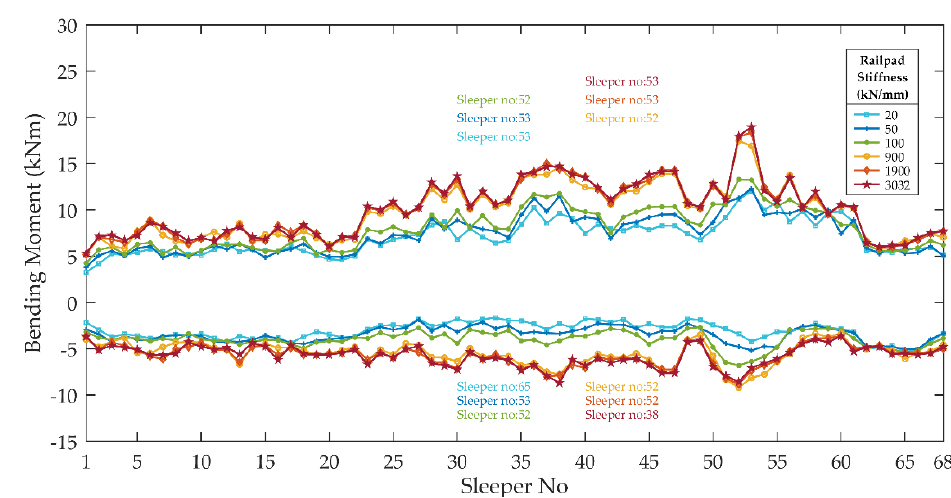
Figure 10. Longitudinal bending moment distributions with reference to different rail pad stiffness.